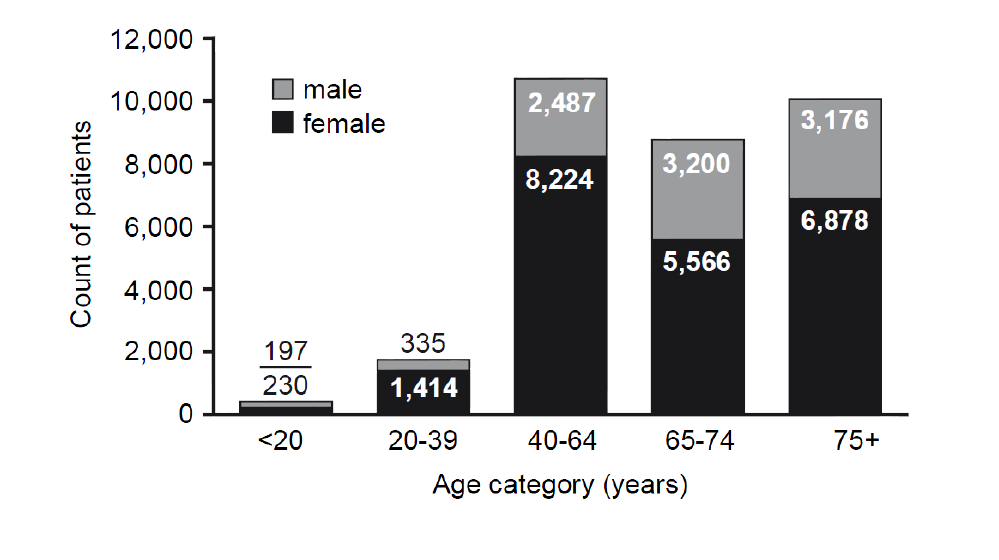
Figure 1. Number of Patients by Age Category and Gender (combined data